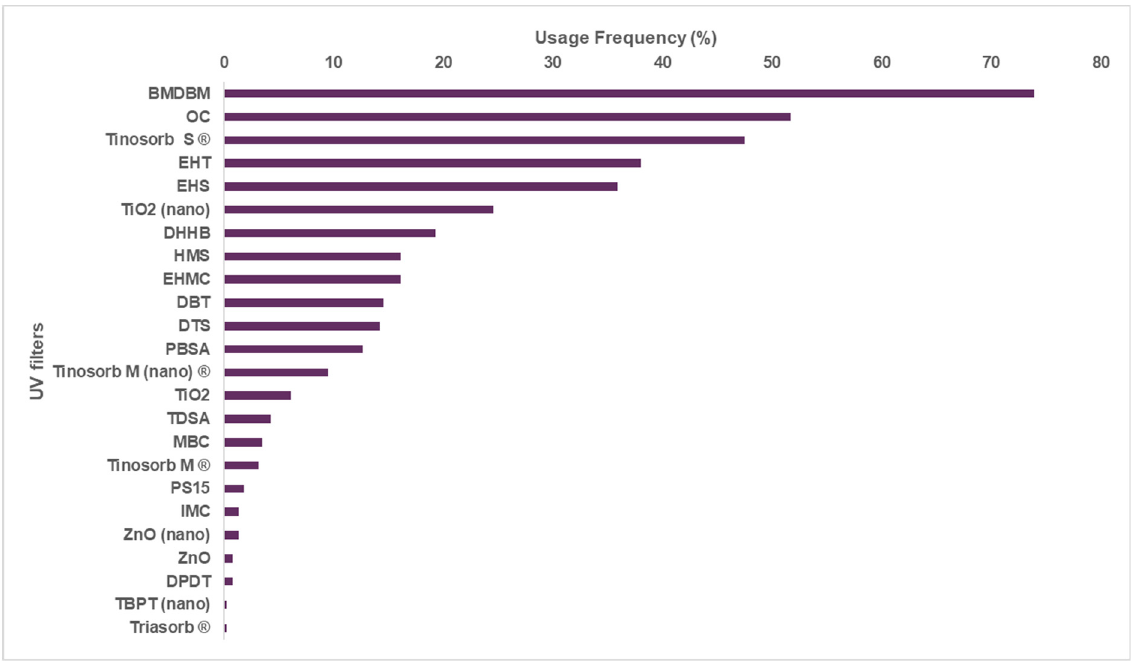
Figure 1. Usage frequency of the UV filters in sunscreens for adults. (BMDBM: butyl methoxydiben- zoylmethane, OC: octocrylene, Tinosorb S ® : bis-ethylhexyloxyphenol methoxyphenyl triazine, EHT: ethylhexyl triazone, EHS: ethylhexyl salicylate, DHHB: diethylamino hydroxybenzoyl hexyl benzo- ate, EHMC: ethylhexyl methoxycinnamate, DBT: diethylhexyl butamido triazone, DTS: dometrizole trisiloxane, PBSA: phenylbenzimidazole sulfonic acid, Tinosorb M ® : methylene bis-benzotriazolyl tetramethylbutylphenol, TDSA: terephthalydidene dicamphor sulfonic acid, MBC: 4-methylbenzyl- idene camphor, PS15: polysilicone-15, IMC: isoamyl p -methoxycinnamate, DPDT: disodium phenyl dibenzimidazole tetrasulfonate, TBPT: tris-biphenyl triazine, Triasorb ® : phenylene bis-diphenyltri- azine.)